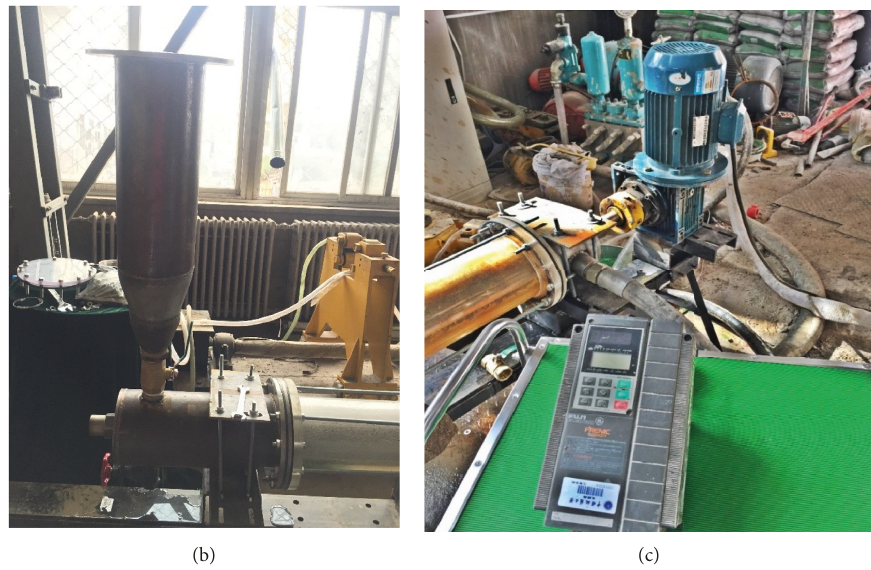
Figure 6: The experimental system used to investigate cuttings-carrying during reverse circulation drilling with dual concentric pipes: (a) Horizontal test section; (b) Sand bucket; (c) Motor and frequency converter for driving the rotation of the drill pipe. Table 3: Herschel-Bulkley parameter values of the flushing fluid. Property